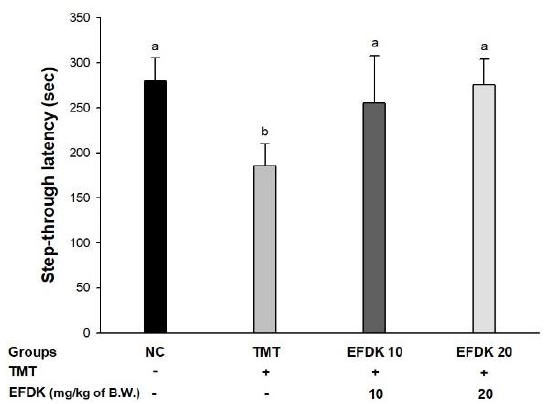
Figure 3. Protective effect of effect of ethyl acetate fraction from persimmon (EFDK) on passive avoidance test in TMT-induced mice. Results shown are mean ± SD ( n = 8). Data were statistically represented at p < 0.05, and different small alphabets mean statistical significance.